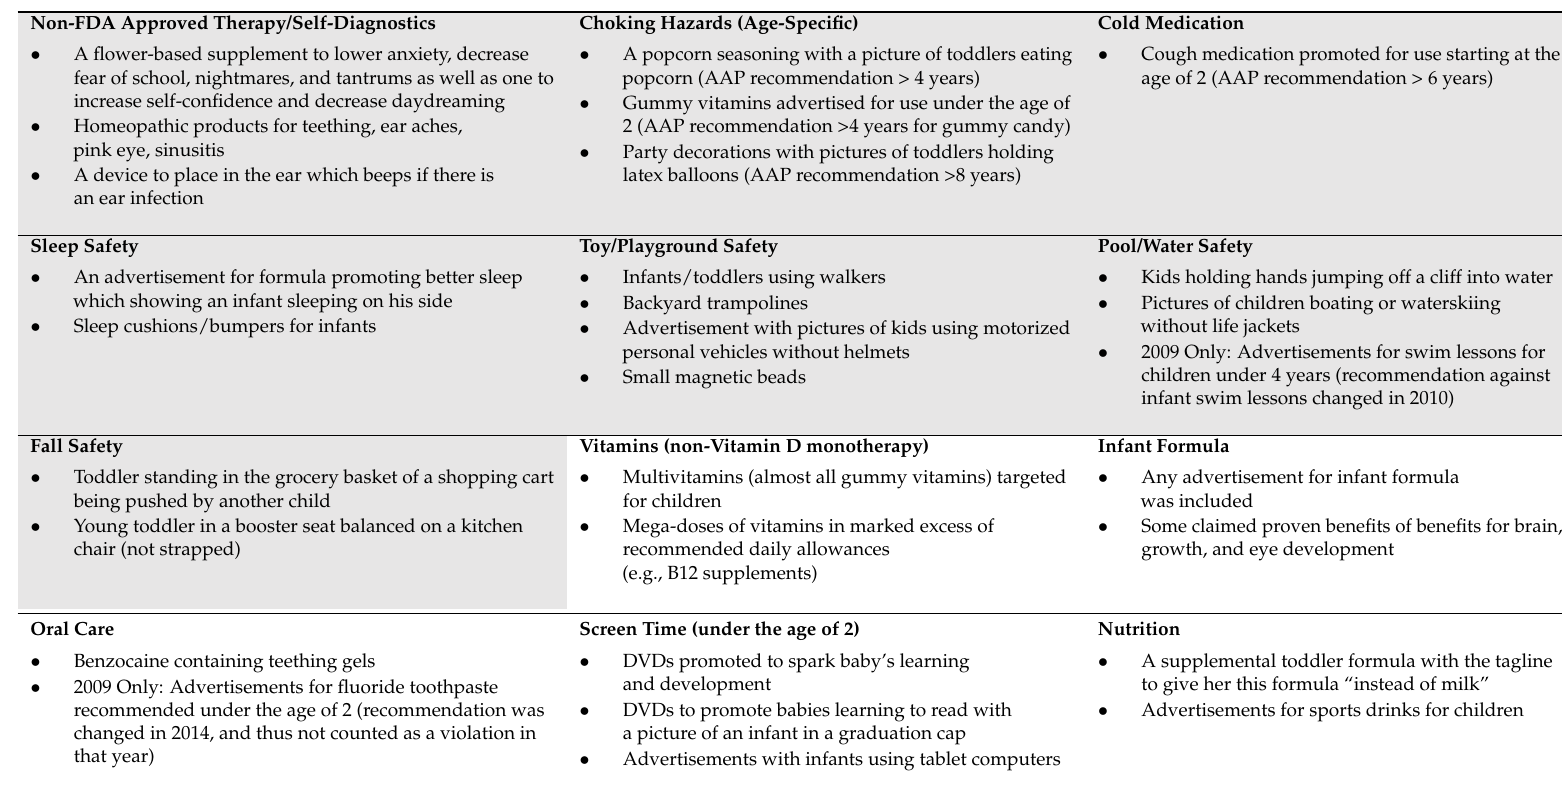
Table 3. Examples of advertisements/products depicting non-adherence for each category of AAP